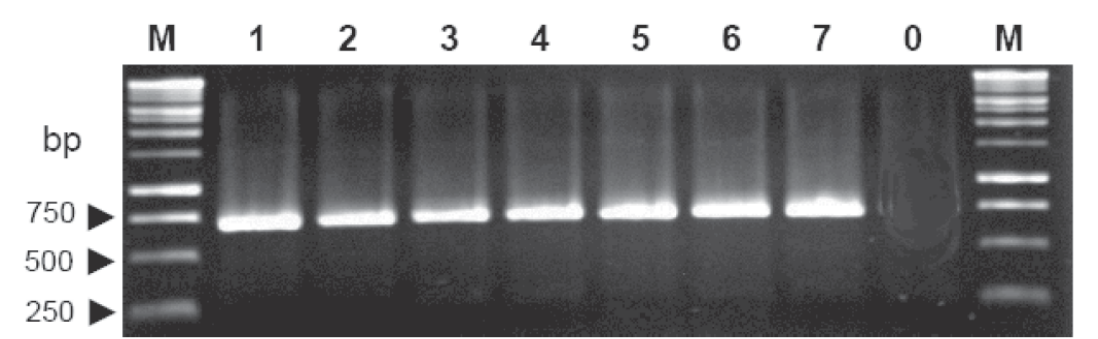
Fig. 2. PCR products obtained with the general primer pair PTYGv568-PTYG1236, using cloned full-length genomic DNA of TYLCSV from Morocco (pTYLCSV-MO-1) and TYLCV from the Dominican Republic (TYLCV-[DO]) as tem- plate. Lane 1, pTYLCSV-MO-1 (1 ng DNA); lane 2, pTYLCSV-MO-1 (0.1 ng); lane 3, TYLCV-[DO] (0.1 ng); lane 4, TYLCV-[DO] (0.01 ng); lane 5, mixture of pTYLCSV-MO-1 (1 ng) and TYLCV-[DO] (0.01 ng); lane 6, mixture of pTYLCSV-MO-1 (0.1 ng) and TYLCV-[DO] (0.01 ng); lane 7, mixture of pTYLCSV-MO-1 (1 ng) and TYLCV-[DO] (0.1 ng); lane 0, no DNA template; M, 1 Kbp ladder